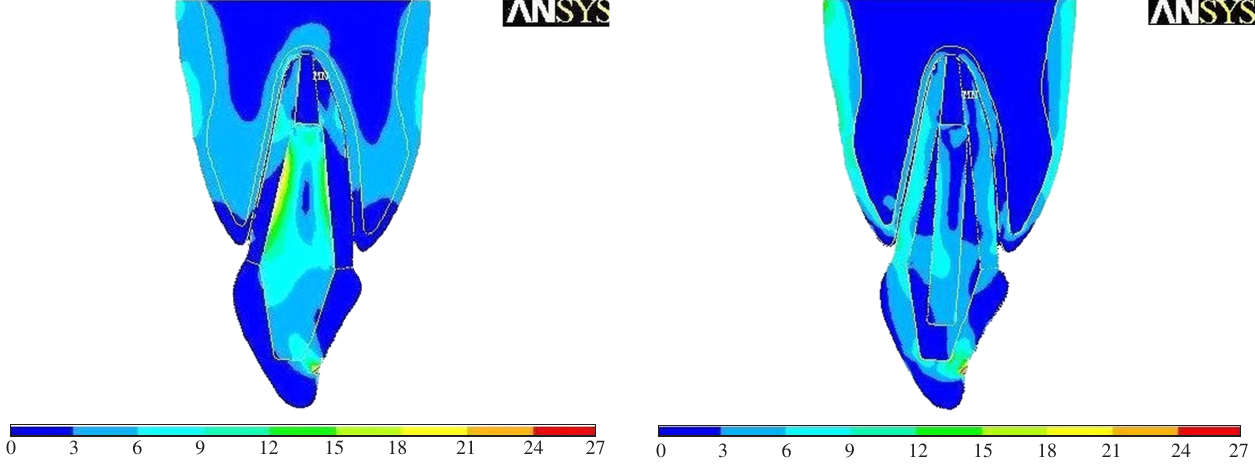
Figure 4. Von Mises equivalent stresses (MPa) in Model 1.